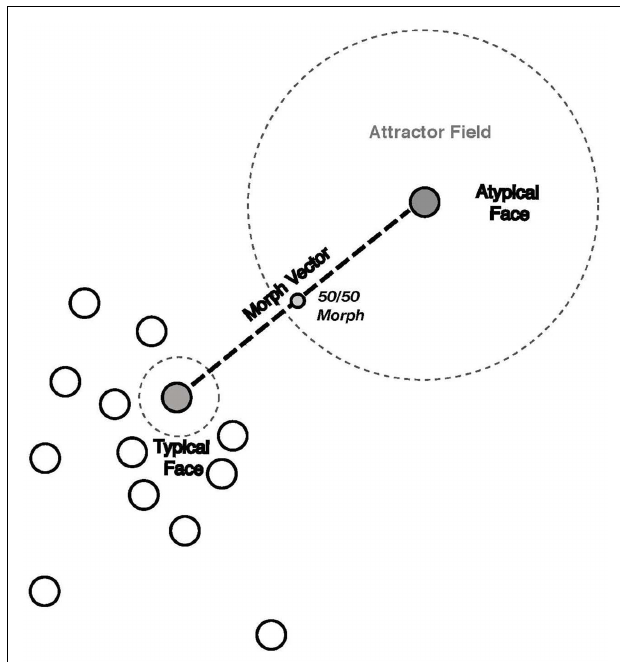
FIGURE 4 | Diagram of the attractor field model. The atypical and typical representations of interest are depicted as filled gray circles. Located in a sparse sub-region of face space, the atypical face representation has a larger attractor field relative to the smaller attractor field of the typical representation situated in a denser sub-region.The morph vector is indicated by the dashed line connecting the atypical and typical parent face representations and morph representations are located along the vector. The 50/50 morph is located at the midpoint of the vector and is equal in its physical distance from its atypical and typical parent representations.The atypicality bias is the result of the 50/50 morph lying closer to attractor boundary of the atypical representation than the typical